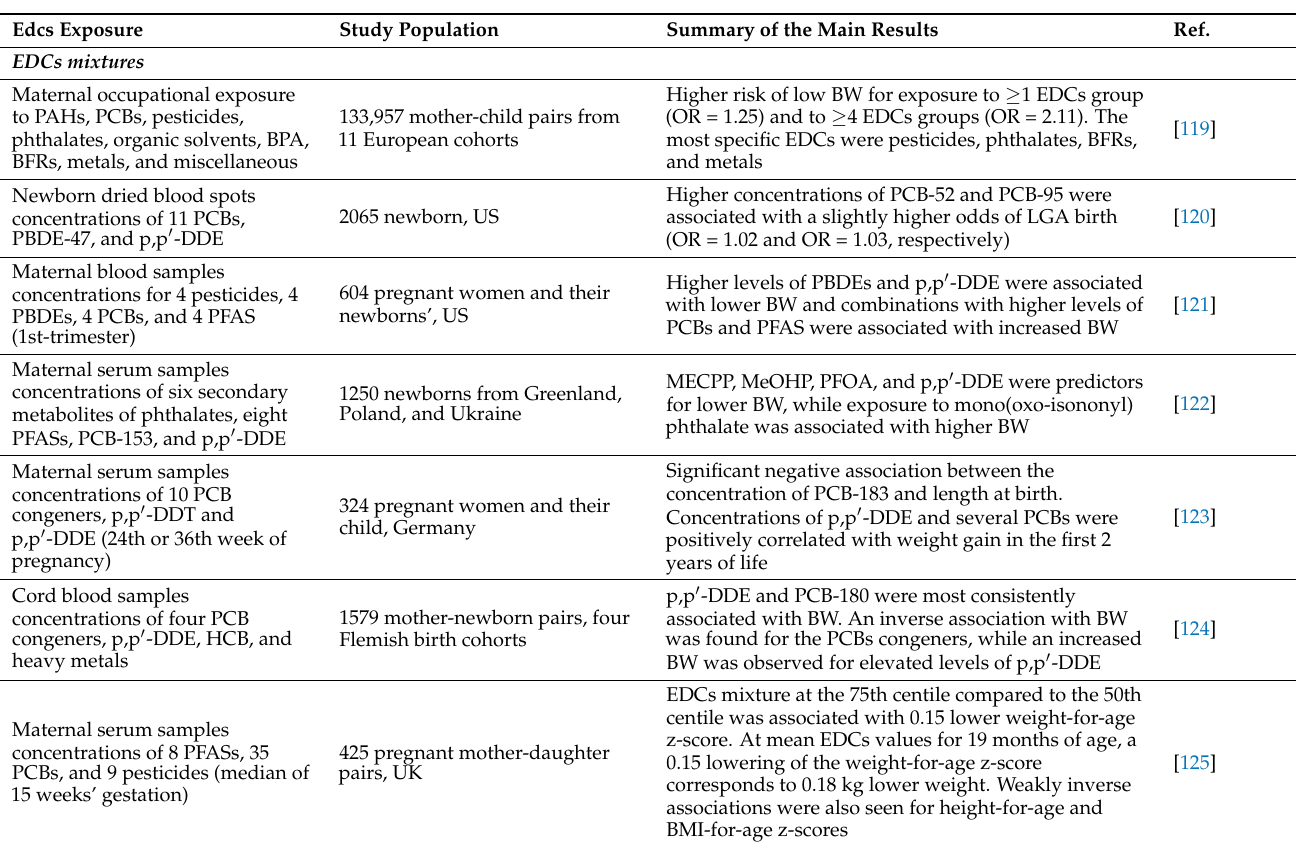
Table 4. Epidemiological data from some studies on pre- and post-natal growth. Summary of the Main